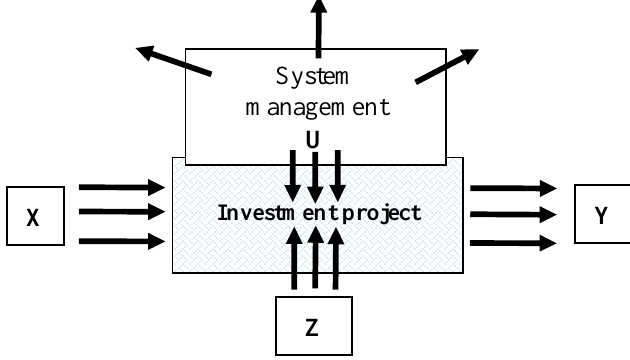
Figure 3. The scheme of formation of uncertainty and risks in the interaction of the enterprise, as a complex socio-economic system, with the